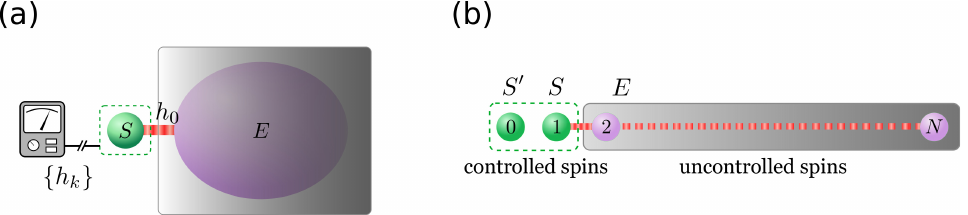
Figure 1. ( a ) A schematic view of the problem setting. A small subsystem S can be directly accessible, while the rest of the system E is beyond direct control; ( b ) A one-dimensional spin chain considered for control in [2]. The two spins at the chain end are in the directly accessible subsystem, and the rest of the chain, E , only evolves through h XX 0